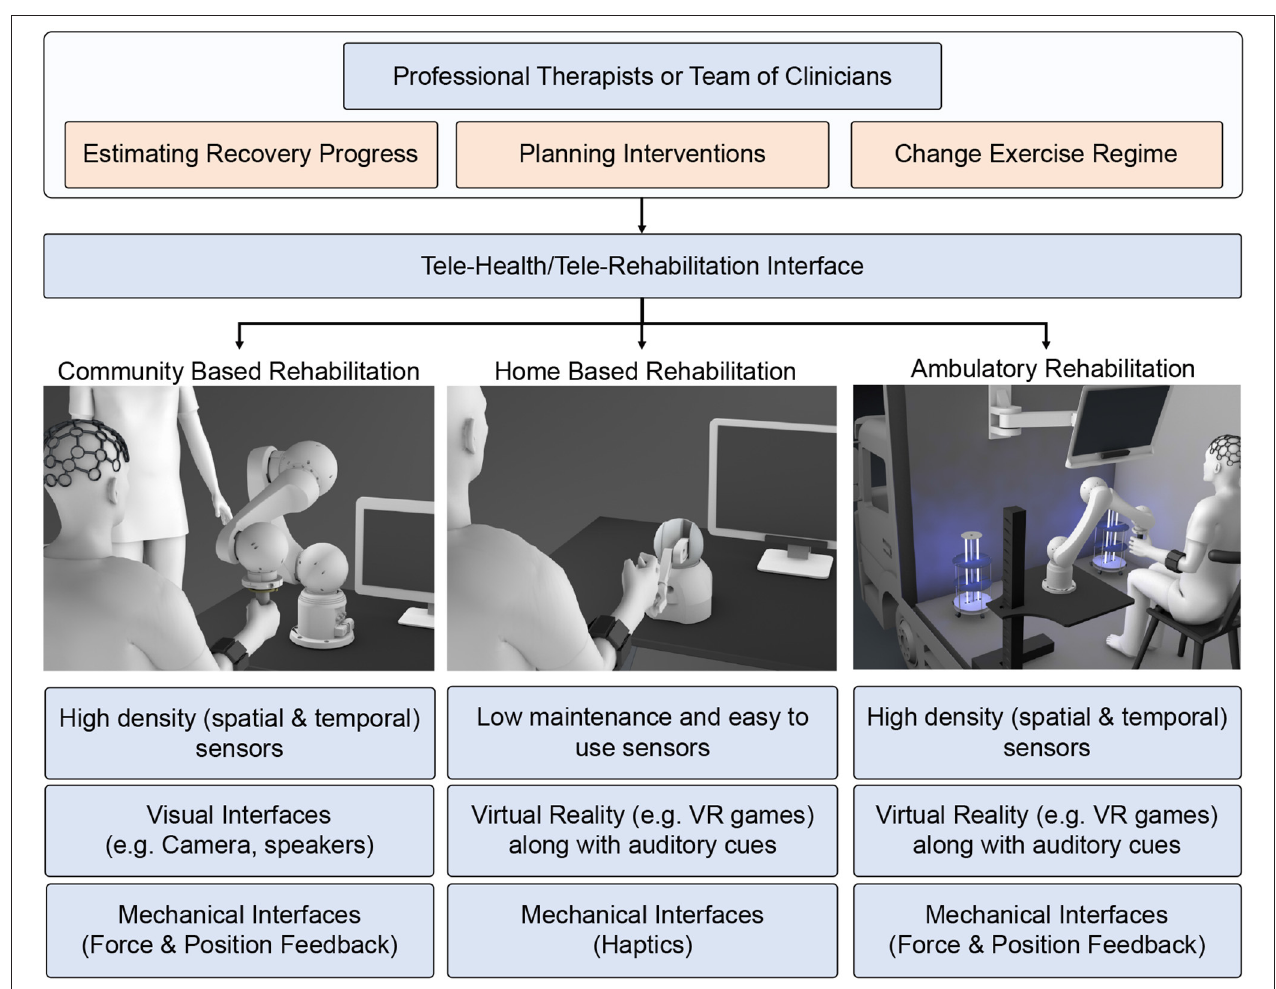
FIGURE 5 | Schematic showing the rehabilitation therapy in three different setups: (1) community-based, (2) home-based, and (3) ambulatory. Present robotic systems are geared toward hospital or home-based approaches. However, due to COVID pandemic, we need to modify and adapt the current system taking into account social distancing norms, emotional stress due to lockdown, and safety of health care workers and